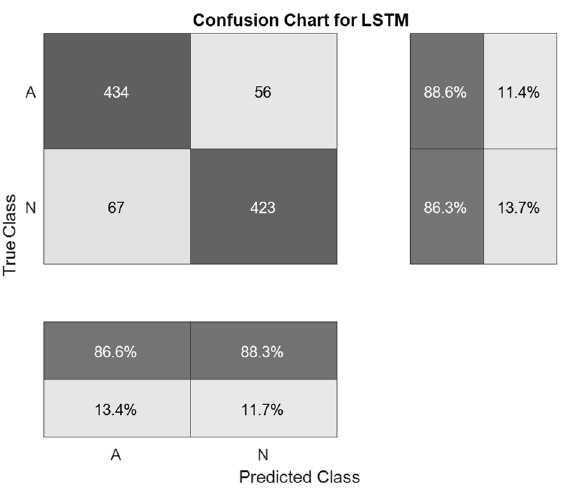
Figure 11. A confusion matrix is a result of the validation of a system for neural network determi- nation of atrial fibrillation on ECG signals with wavelet-based preprocessing.